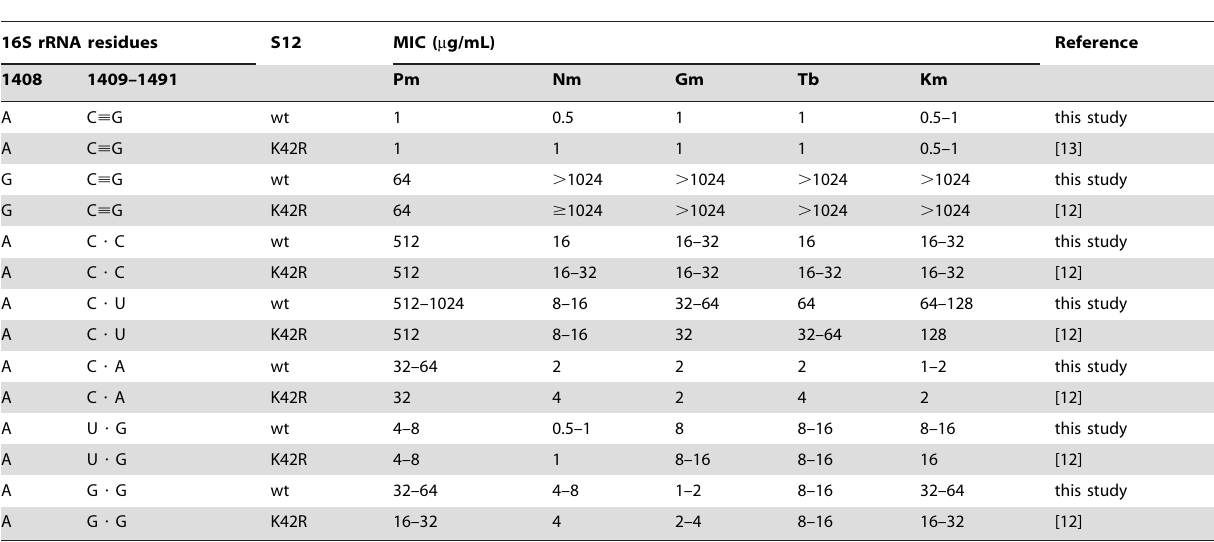
Table 1. Drug susceptibility of M. smegmatis 16S rRNA mutants: wild-type S12 versus K42R.